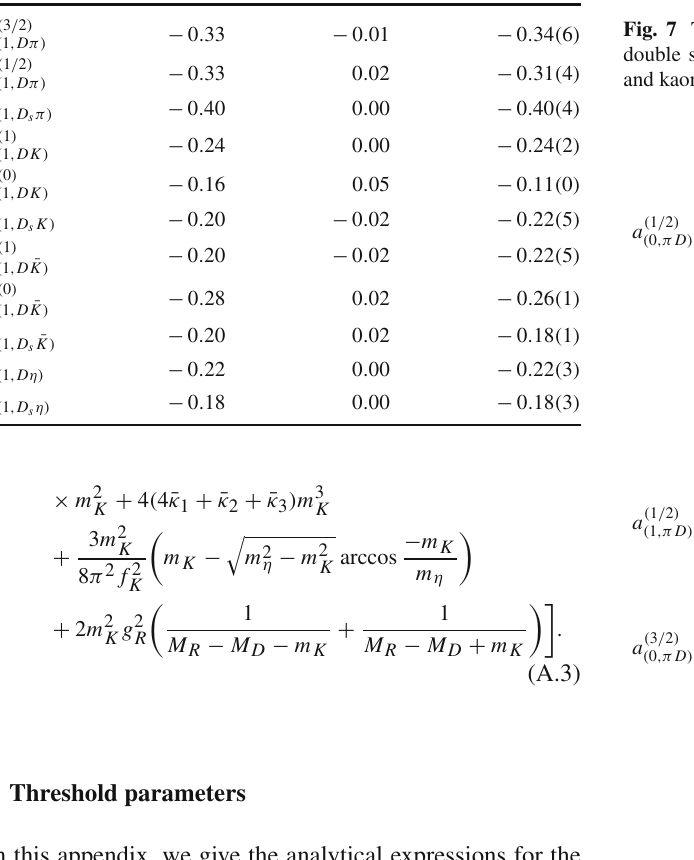
Table4 Predictionsofthescatteringvolumesforthelightpseudoscalar meson and D meson at the physical meson values. The scattering vol- umes are in units of fm 3 . Note that, the values for the O ( p ) in all channels are zero, and are not shown Sca. Vol.